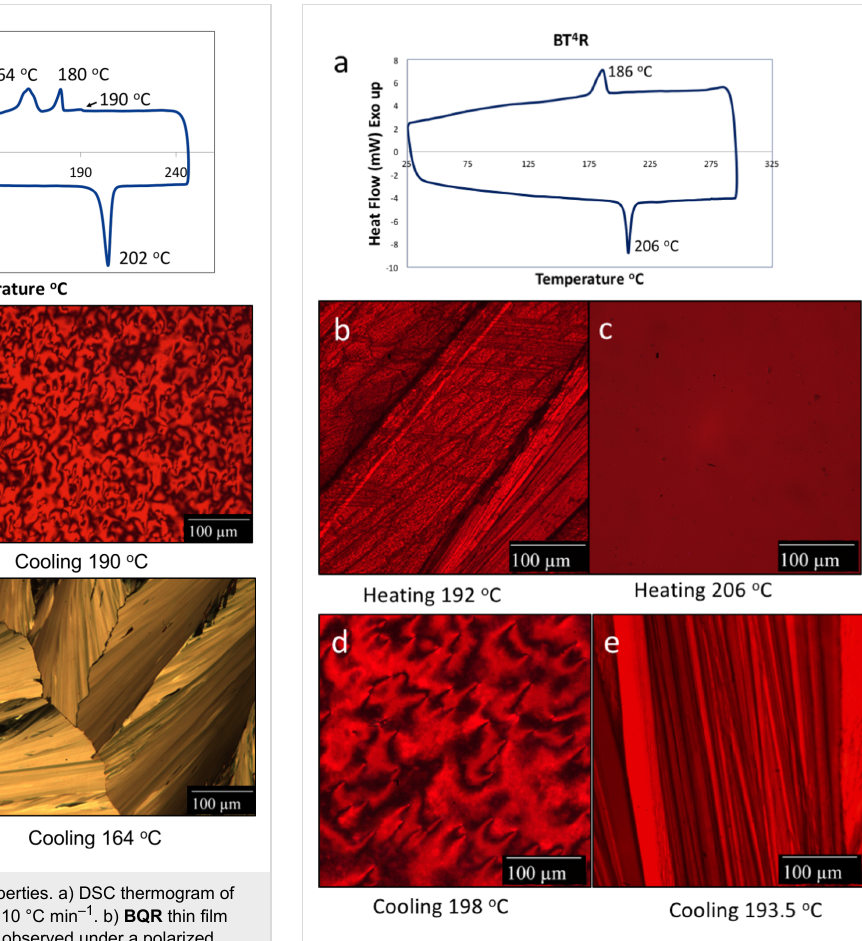
Figure 3: BT 4 R thermal and POM images. a) DSC thermogram of BT 4 R under nitrogen at a ramp rate of 10 °C min − 1 . b) BT 4 R thin film sandwiched between two glass slides observed under a POM at 192 °C on heating. c) POM image of the same film when the stage temperature is at 206 °C, d) POM image when the stage temperature is lowered to 198 °C with distinct Schlieren texture for a NLC, and e) POM image when the stage temperature is lowered to 193.5